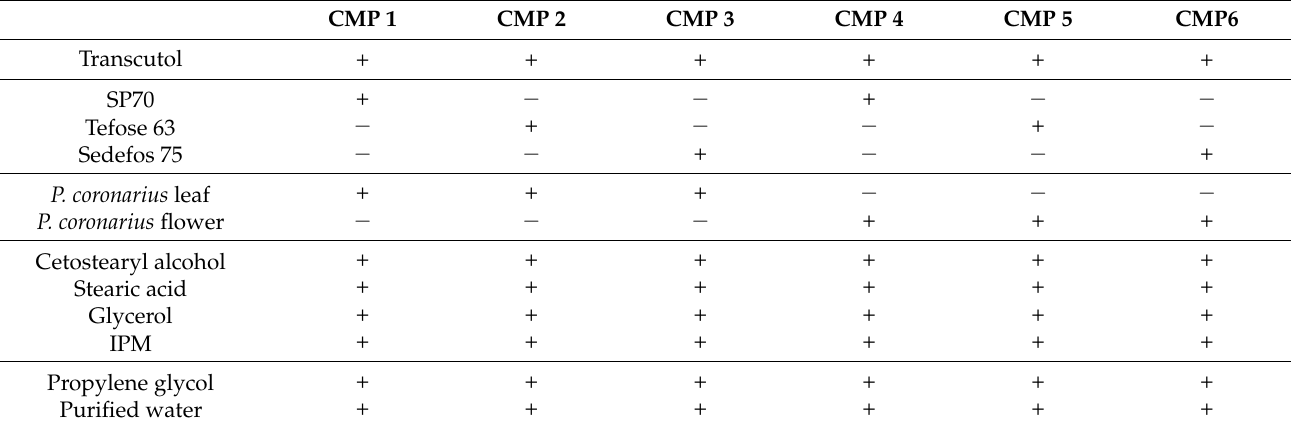
Table 10. Composition (CMP) of the